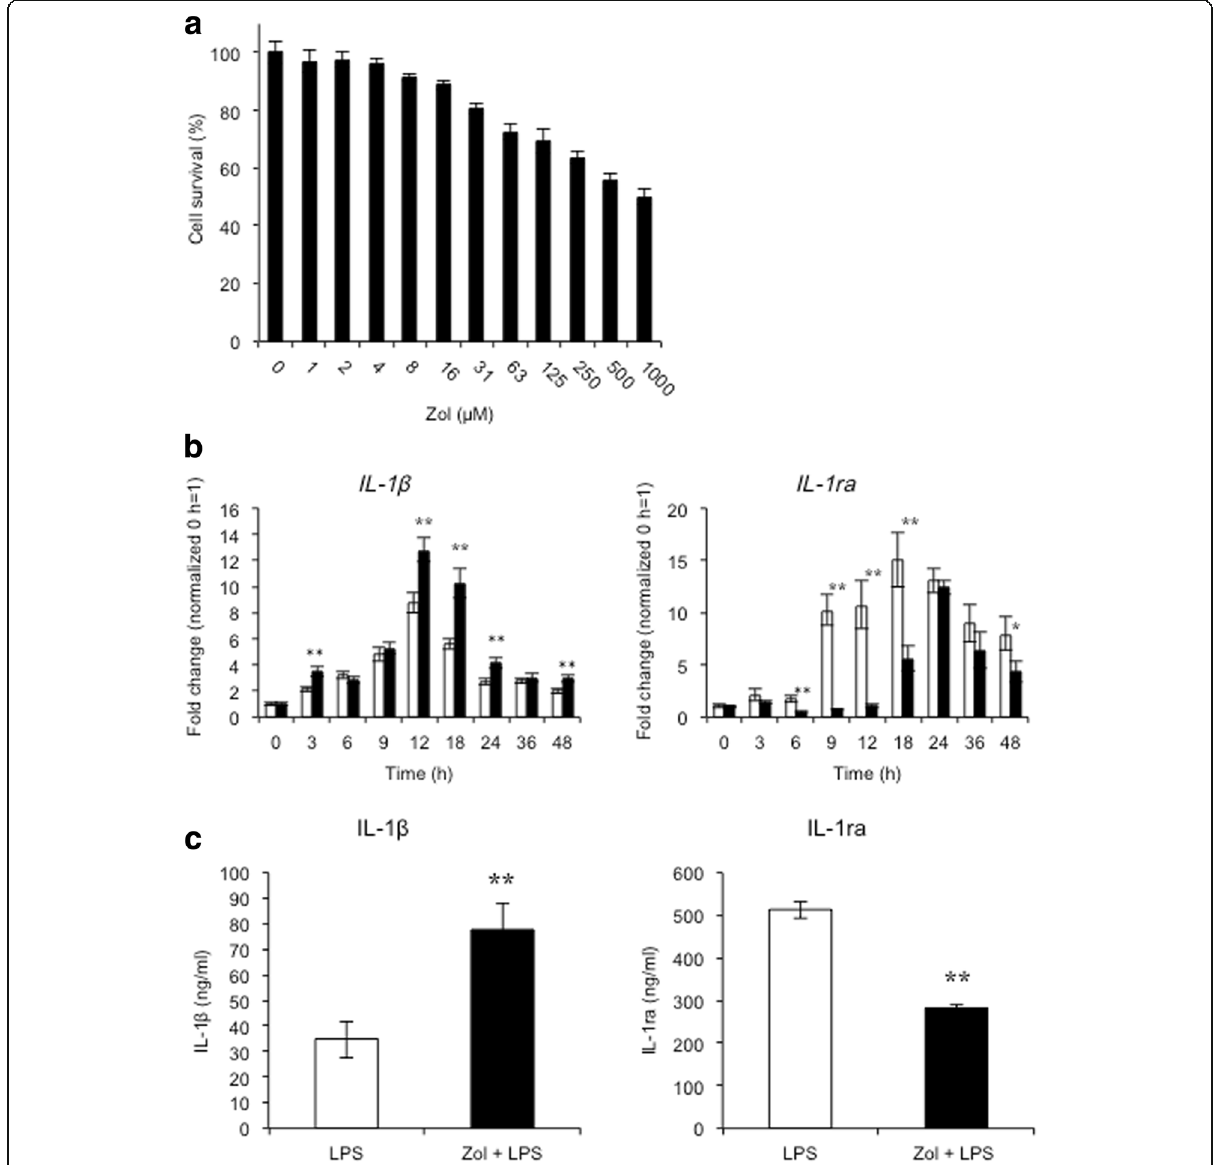
Fig. 1 Effects of zoledronic acid on the expression of M1/M2 macrophage markers in LPS-treated THP-1 cells. THP-1 cells were treated overnight with 100 ng/ml PMA, then washed and incubated for 24 h. a Cell viability was assessed using a WST-8 assay after treatment with Zol (1 – 1000 nM) for 48 h. b THP-1 cells were incubated with or without Zol for 24 h and then treated with 100 ng/ml LPS. Open bars represent LPS-treated THP-1 cells; filled bars represent Zol and LPS-treated THP-1 cells. Zol upregulated the expression of IL-1 β mRNA and downregulated the expression of IL-1ra mRNA in LPS-treated THP-1 cells ( * P <0.05, * * P <0.01 vs. cells treated with LPS alone). c ATP was applied to LPS-treated cells for 30 min before collecting samples. The secretion of IL-1 β at 18 h and IL-1ra at 36 h was detected by ELISA. Zol upregulated the secretion of IL-1 β and downregulated the secretion of IL-1ra in LPS-treated THP-1 cells (* * P <0.01 vs. cells treated with LPS